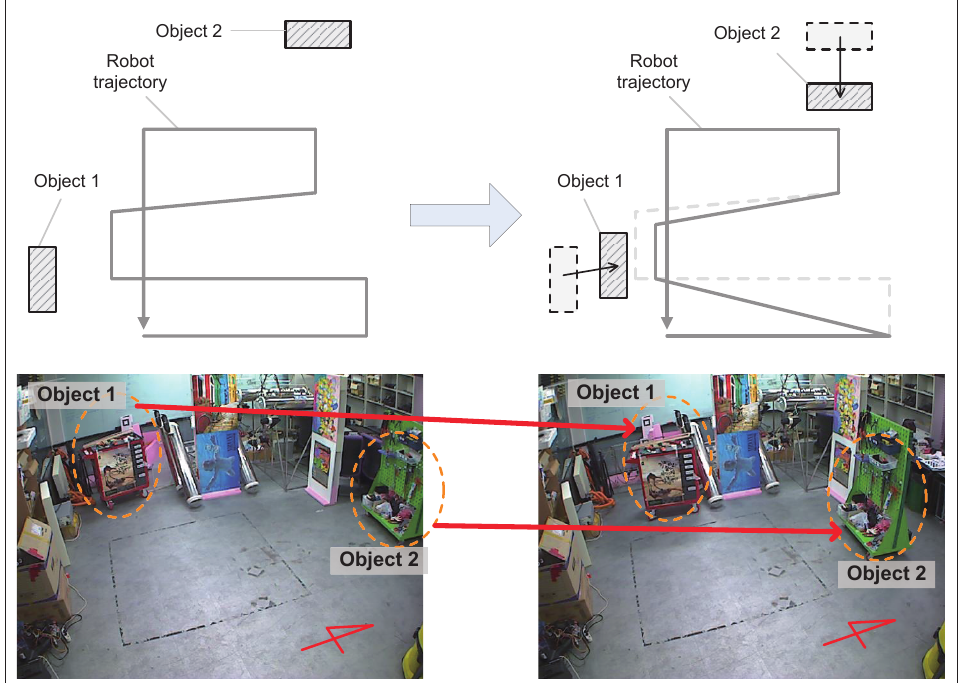
Figure 18. Relocations of the two tool carts during experiment 3 that produces a low dynamic